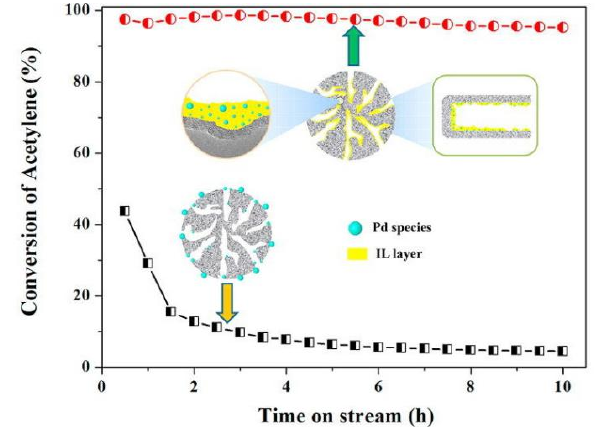
Figure 15. Supported IL-Pd catalyst for acetylene hydrochlorination [106].